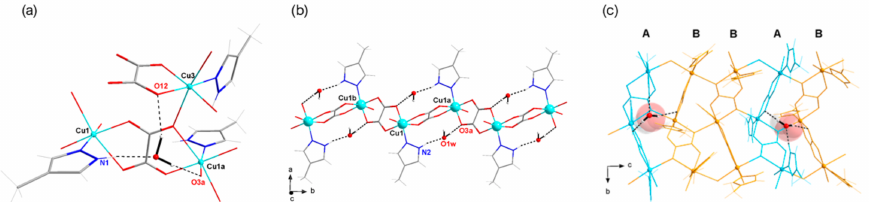
Figure 3. ( a ) A view of the three-fold H-bonding motif involving the water molecule of crystallization in 1 . ( b ) A view of the H-bonds established between the water molecules of crystallization and each A type chain in 1 . ( c ) Projection along the crystallographic a axis of a fragment of one oxalate-copper(II) layer, with A and B type chain fragments shown in different colors for clarity, aiming at illustrating both intra- and inter-chain (intralayer) H-bonding interactions that involve the water molecule of crystallization. H-bonds are depicted as dashed